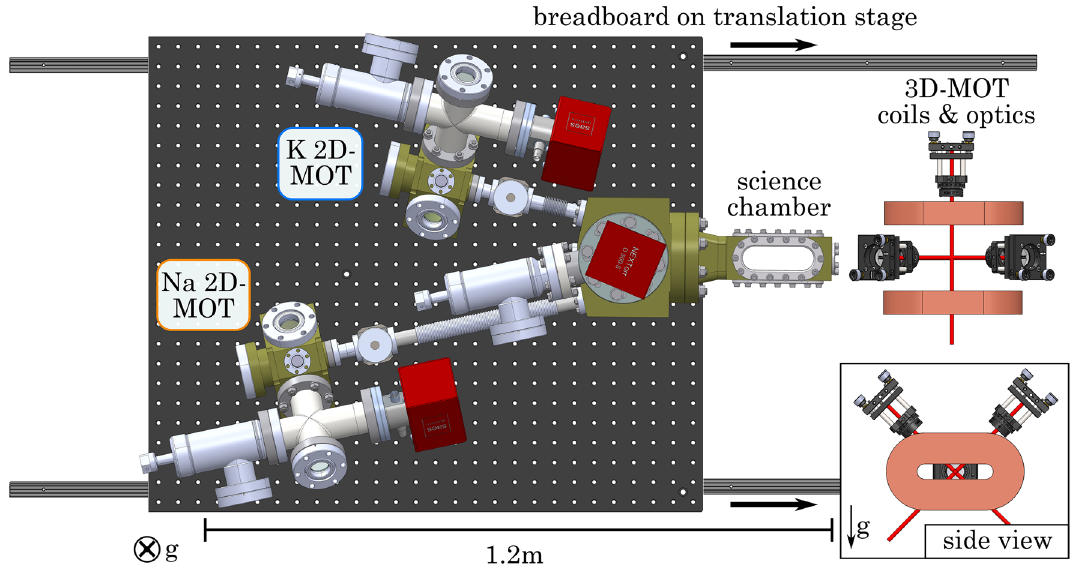
Figure 2. Vacuum system. The separated 2D-MOT chambers are connected from the same side to the dual- species science chamber. The vacuum pumps are shown in red. The whole vacuum system is mounted on a translation stage, such that the science chamber can be moved out of the region of the 3D-MOT coils and